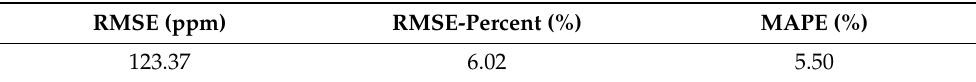
Table 8. Root mean square error (RMSE) and mean accuracy percentage error (MAPE) of the CONTAM simulation results of the CO 2 concentration in D Elementary School.